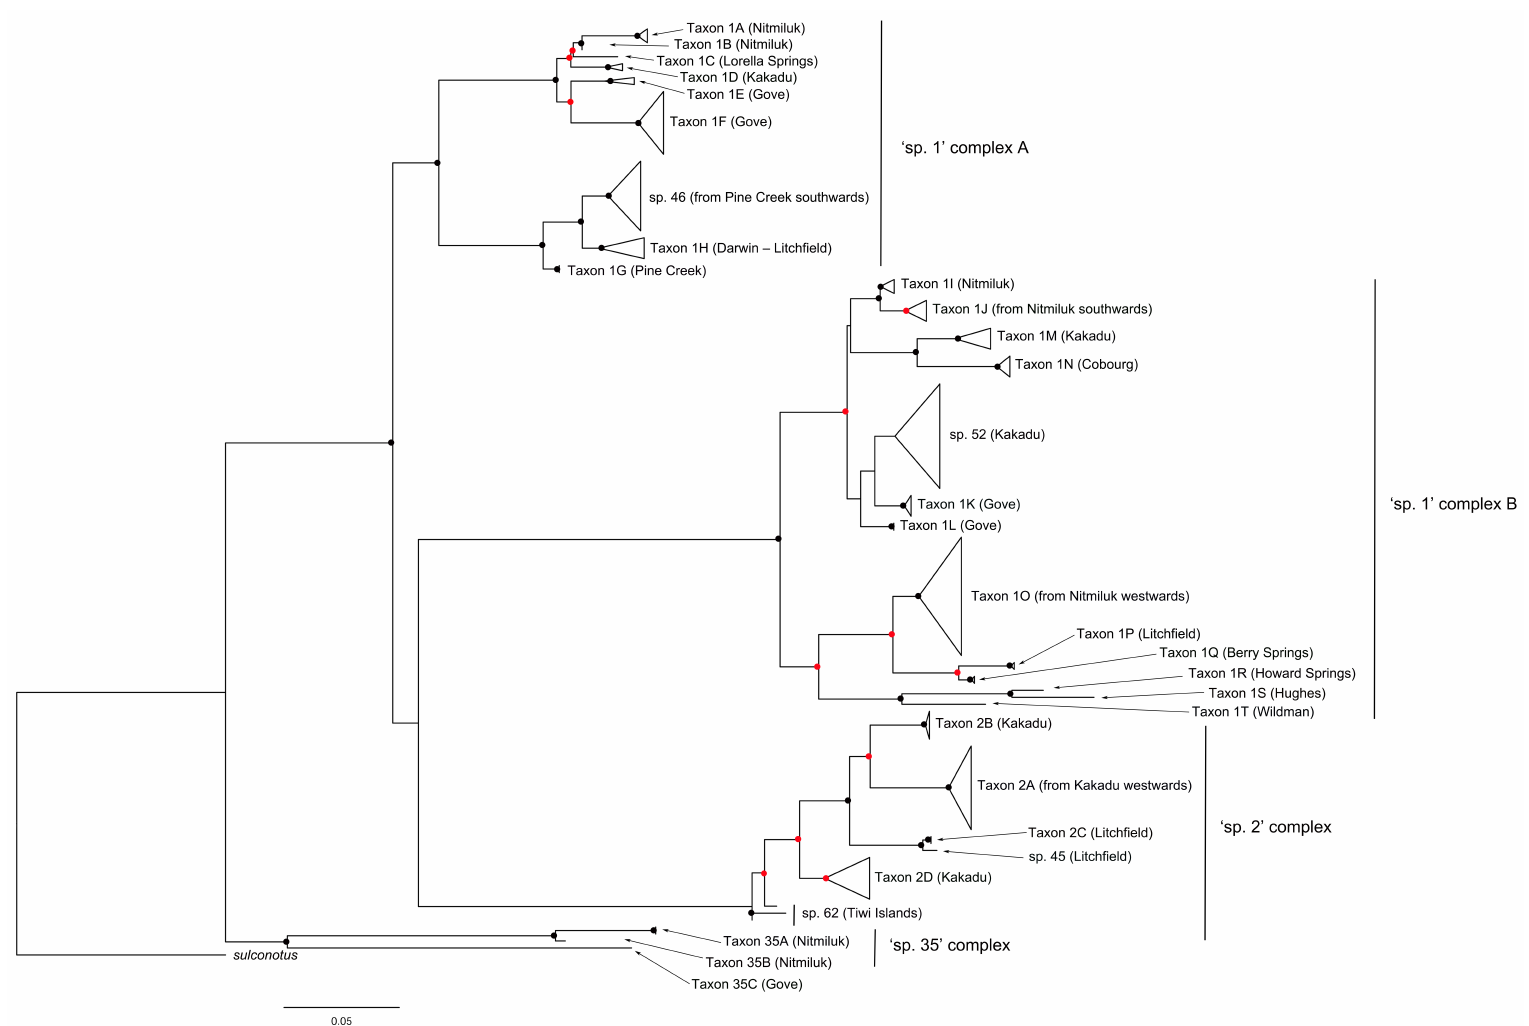
Figure 6. Summary CO1 tree of specimens from the Melophorus rufoniger group. Red and black circles indicate bootstrap values ≥ 70% and ≥ 90%, respectively. The full CO1 tree is shown in Supplementary Figure